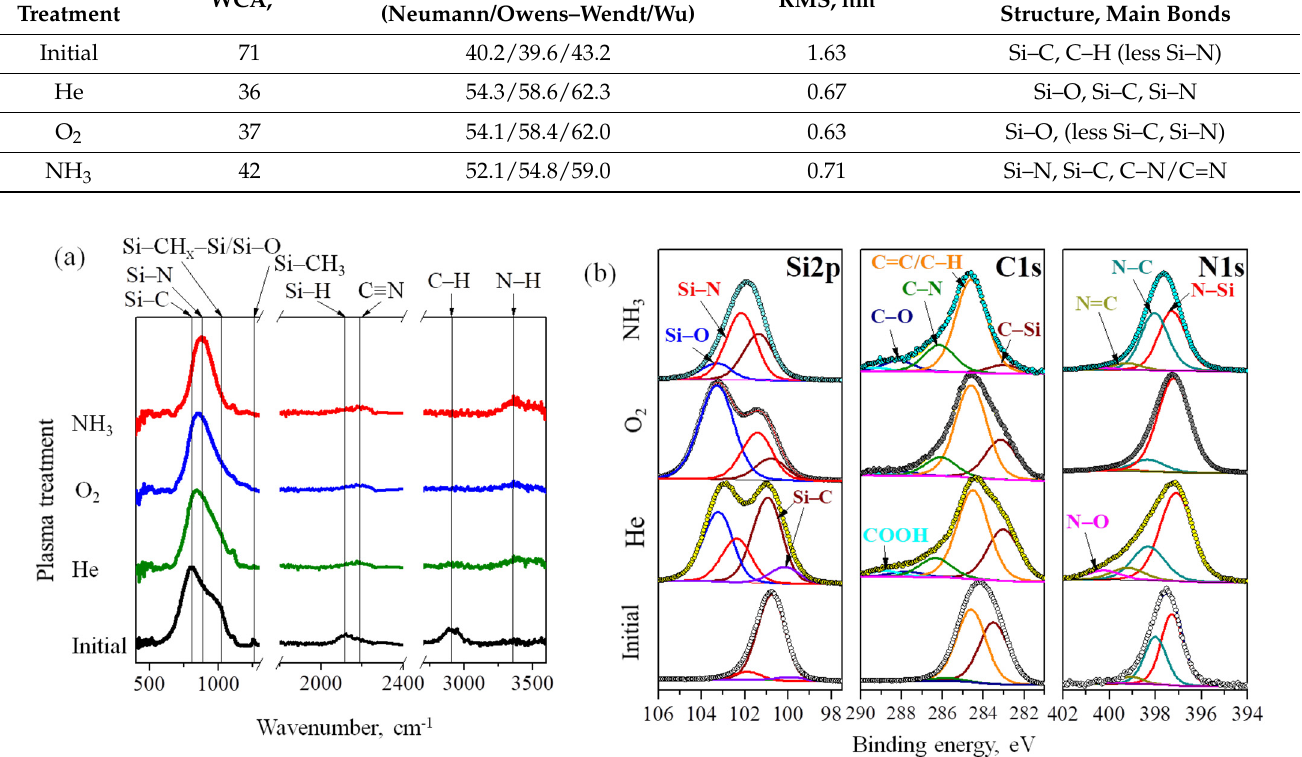
Figure 9. FTIR ( a ) and XPS ( b ) Si2p, C1s, N1s core-level spectra of initial SiCN film and after He, O 2 or NH 3 plasma treatment in helium, oxygen, and ammonia.